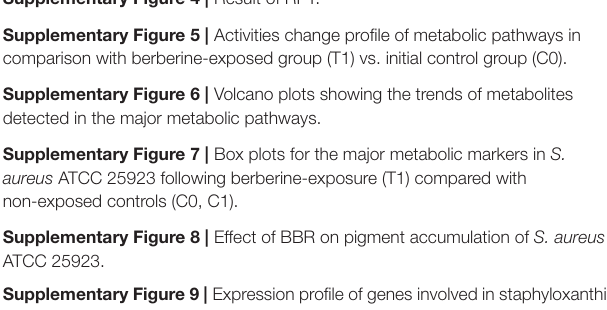
Supplementary Text 1 | Details for untargeted metabolomics analyses. Supplementary Figure 1 | MIC test of BBR combined with vancomycin against S. aureus ATCC 25923. Supplementary Figure 2 | The effect of BBR on survival of S. aureus ATCC 25923. Supplementary Figure 3 | Growth curves (A) and the results of time kill tests (B) for S. aureus ATCC 25923 in the presence (1/4MIC, 3/8MIC, 1/2MIC or MIC) or absence (control) of berberine. Supplementary Figure 4 | Result of RPT. Supplementary Figure 5 | Activities change profile of metabolic pathways in comparison with berberine-exposed group (T1) vs. initial control group (C0). Supplementary Figure 6 | Volcano plots showing the trends of metabolites detected in the major metabolic pathways. Supplementary Figure 7 | Box plots for the major metabolic markers in S. aureus ATCC 25923 following berberine-exposure (T1) compared with non-exposed controls (C0, C1). Supplementary Figure 8 | Effect of BBR on pigment accumulation of S. aureus ATCC 25923. Supplementary Figure 9 | Expression profile of genes involved in staphyloxanthin biosynthesis in S. aureus ATCC 25923 responsive to berberine-exposure. Supplementary Table 1 | Parameters of OPLS-DA and RPT